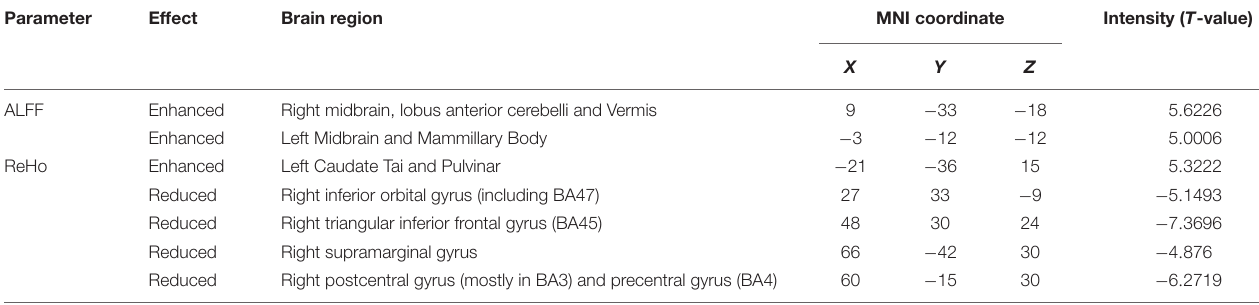
TABLE 2 | Regions of DH showing significant changes in ALFF and ReHo values compared with HS. Parameter Effect